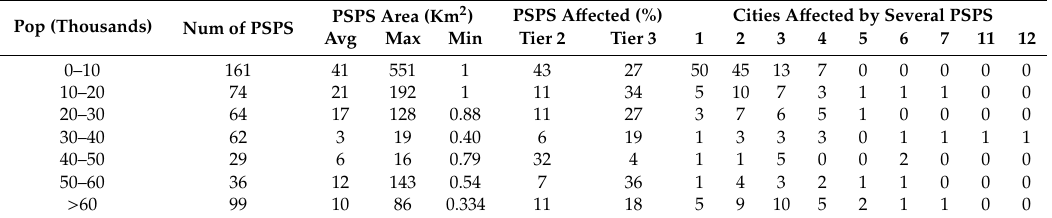
Table 2. Cities in SCE PSPS zones under Tier 2 (Elevated) or Tier 3 (Extreme) Fire-Threat.